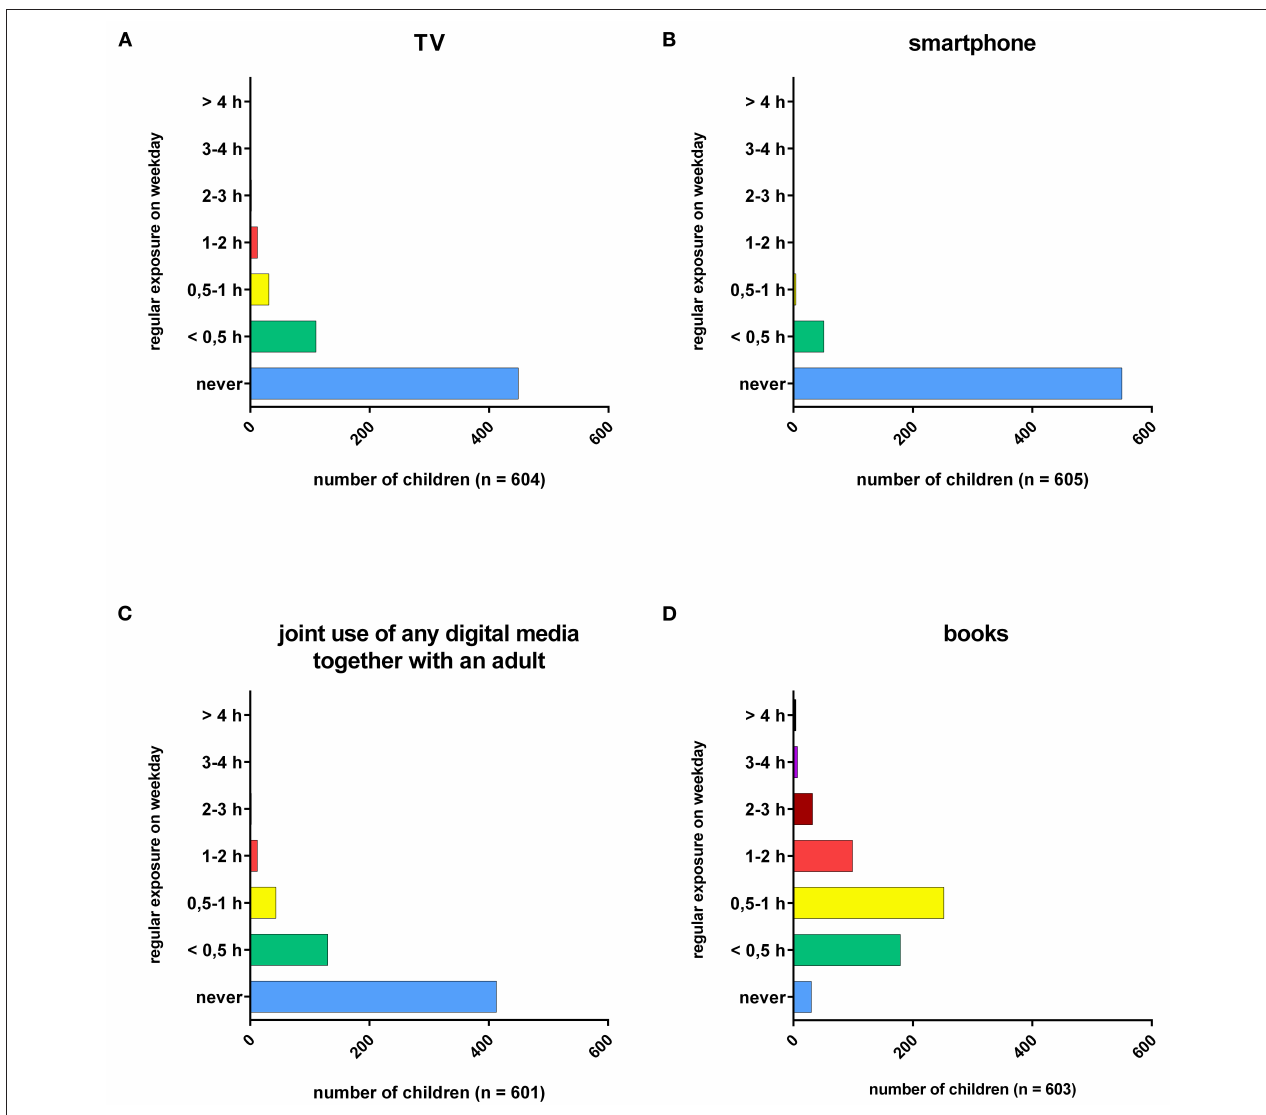
FIGURE 1 | Regular exposure time (in hours) to different types of media on weekdays.